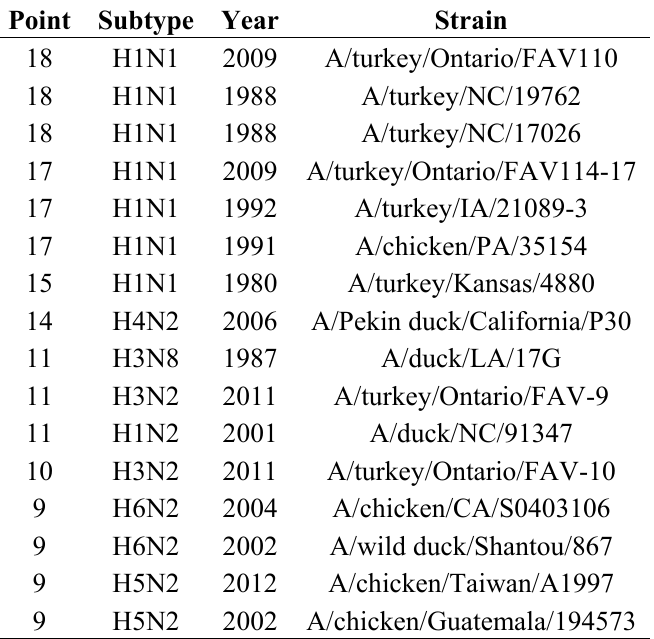
Table 2. Potentially hazardous avian